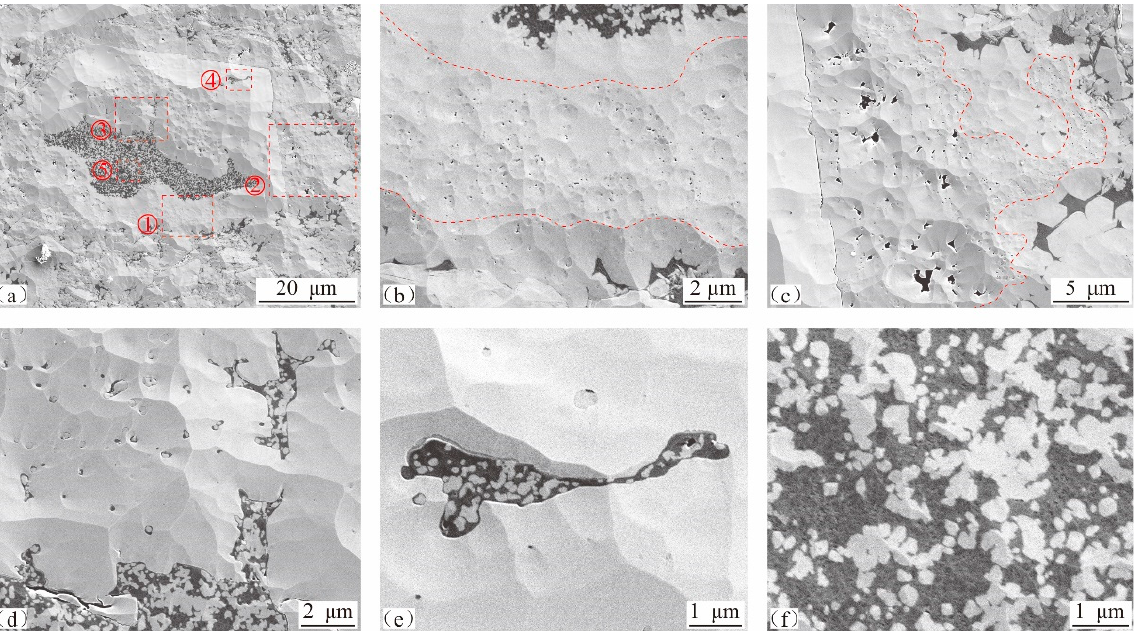
Figure 5. Typical images of uncompleted radiolarian siliceous shells with calcite and organic–silicon complex in cavities. ( a ) Uncompleted radiolarian siliceous shell cavity filled with calcite and organic–silicon complex. ( b ) Enlargement of No. ① red box in image ( a ), three layers of shell. ( c ) Enlargement of No. ② red box in image ( a ), calcite contacting with middle layer. ( d ) Enlargement of No. ③ red box, organic–silicon complex filling dissolved pores at the edge and inside of calcite. ( e ) Enlargement of No. ④ red box, organic–silicon complex filling dissolved pores within calcite. ( f ) Enlargement of No. ⑤ red box, organic–silicon complex.